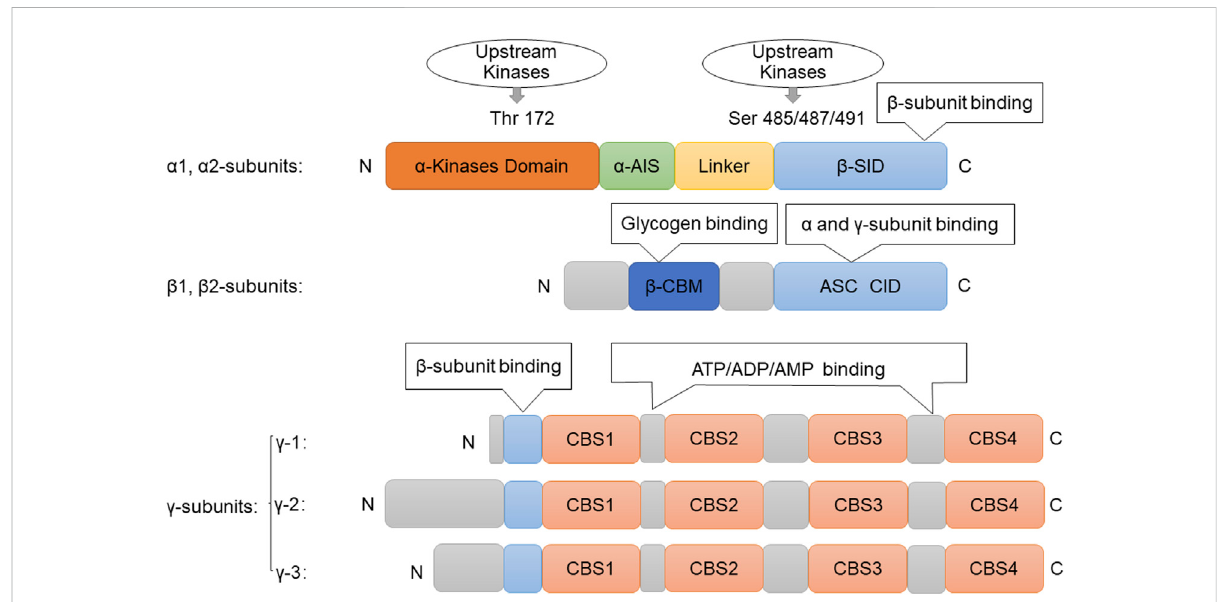
FIGURE 1 Structure of AMPK. Picture of the components of the AMPK subunits. The catalytic α -subunit can be phosphorylated at Thr172by upstream kinasesincluding,LKB1, CaMKK β ,andTAK1,leadingtoenzymeactivation.The β -subunit contains aglycogen-bindingdomain(GBD).The γ -subunits contain four nucleotide-binding modules (CBS domains), which can synergistically bind AMP, ADP, and ATP. Abbreviations: AMPK, adenosine monophosphate-activated protein kinase;ATP, Adenosine triphosphate;ADP, adenosine diphosphate; AMP,adenosinemonophosphate; ASC, association with Snf1 complex domain; AIS, autoinhibitory sequence; CBM, carbohydrate-binding module; CBS, cystathionine- β -synthase domain; Thr, threonine; Ser, serine; GBD, glycogen bind domain; SID, subunit interacting